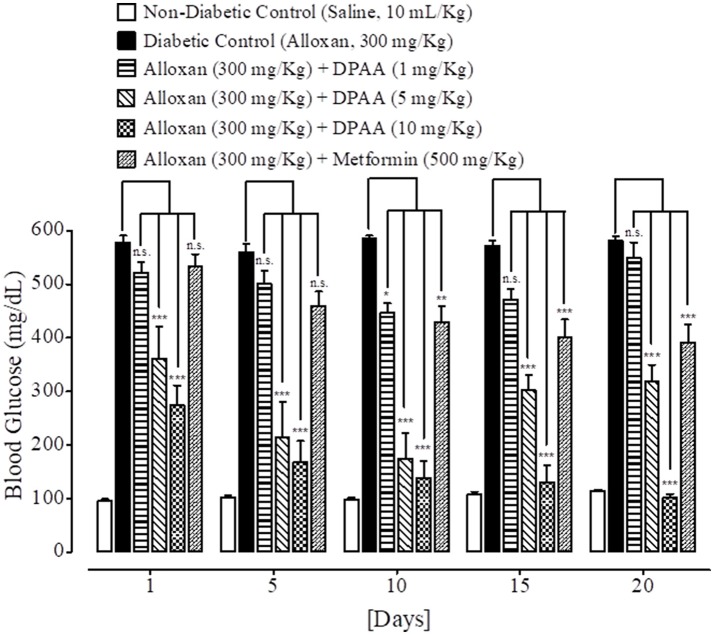
Bar-graph representing blood glucose levels at different treatment days of saline treated group (non-diabetic control), alloxan treated group (diabetic control), inhibitory effect of bis (diphenylacetato) cadmium (II) (DPAA) at different doses (1–10 mg/Kg) and metformin treated group against alloxan-induced hyperglycemia in mice. Data presented as mean ± SEM. Statistical analysis used one-way ANOVA, followed by post-hoc Tukey's test. *P < 0.05, **P < 0.01, ***P < 0.001 comparison of the blood glucose levels of DPAA and metformin treated groups vs. diabetic control group. n.s., non-significant. The sample size in each group comprised of five mice (n = 5).